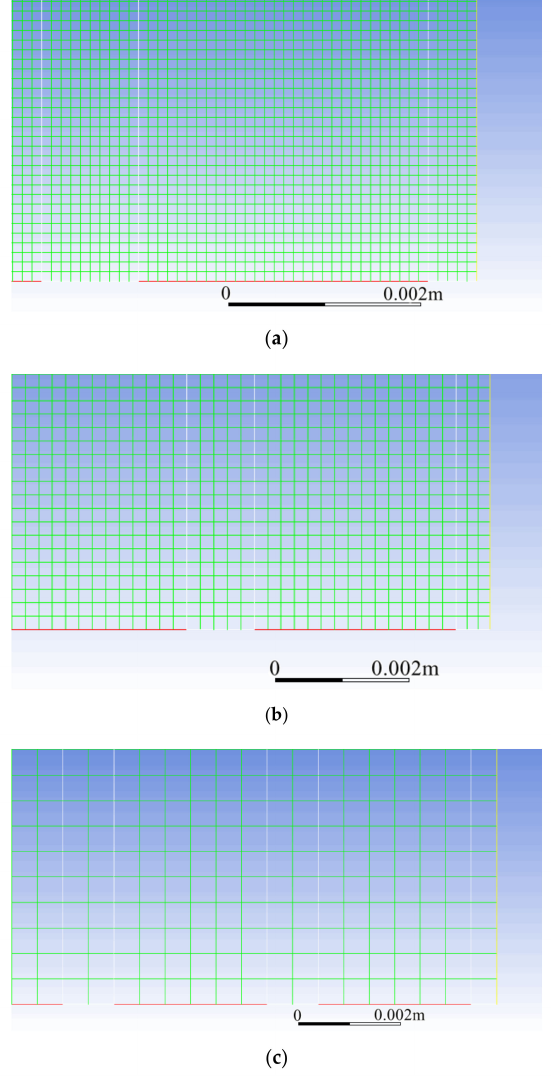
Figure 6. Grid at the outlet of Case2. ( a ) The grid size of Case2 = 0.1 mm; ( b ) The grid size of Case2 = 0.2 mm; ( c ) The grid size of Case2 = 0.5